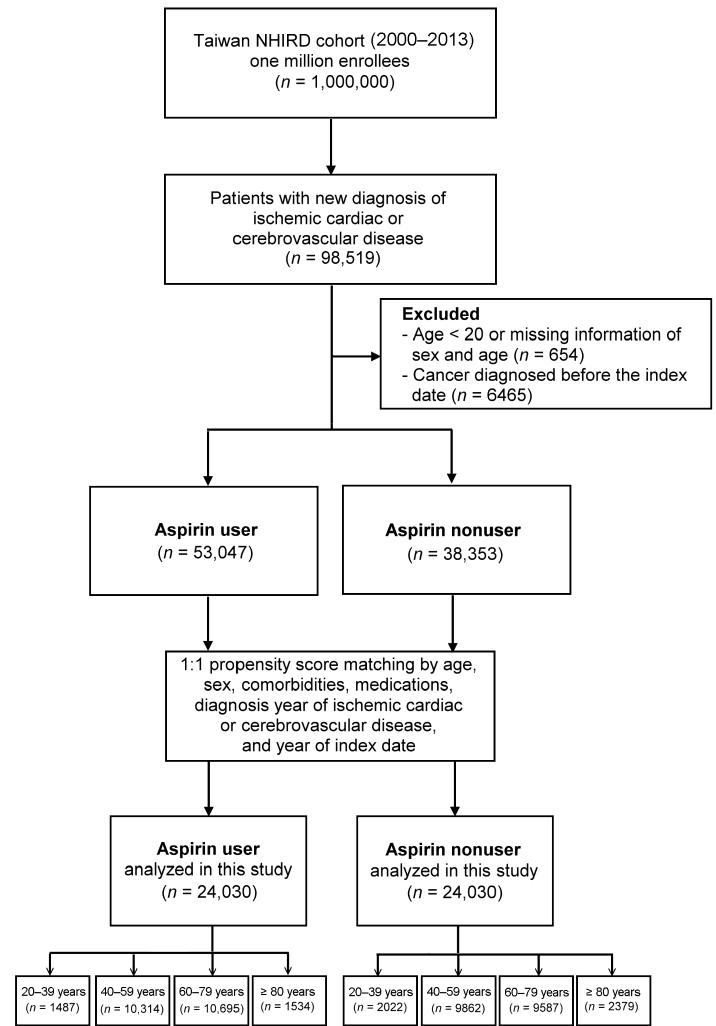
Figure 1. Flowchart of patient selection. NHIRD, National Health Insurance Research Database.